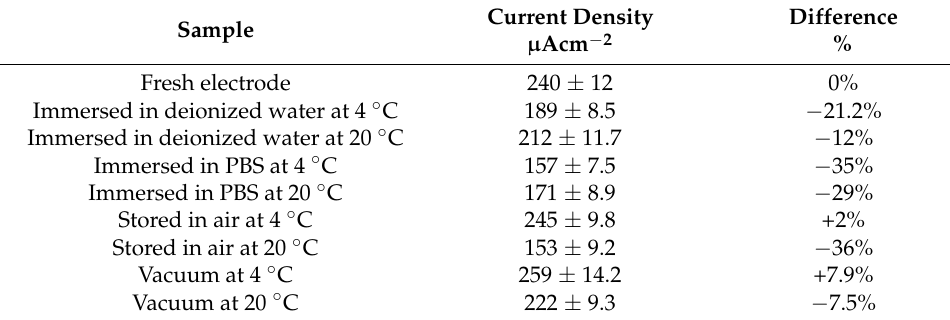
Table 3. Stability of the AuNPs-rGO-based sensors after 21 days of storage. Current Sample